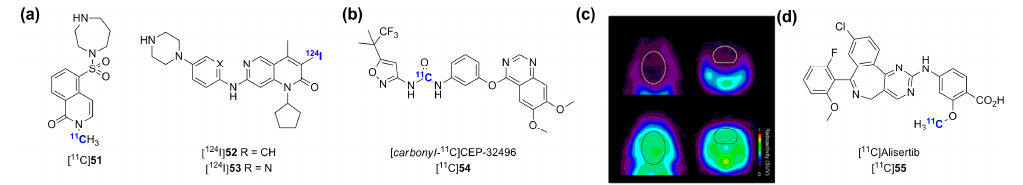
Figure 16. Chemical structures of recently synthesized serine/threonine kinase